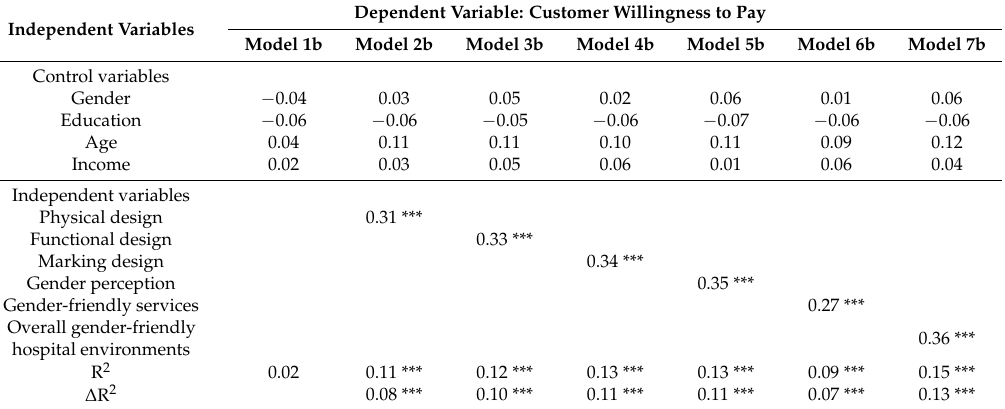
Table 7. Regression analysis for the effects of gender-friendly hospital environments on customer willingness to